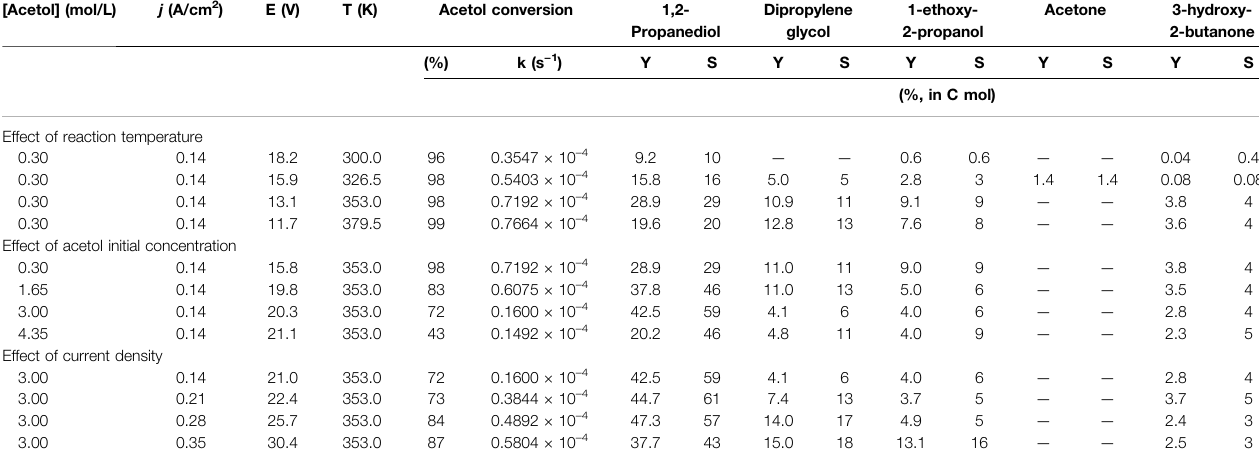
TABLE 1 | 1,2-propanediol and minor products selectivity and yield under different conditions after 8 h of reactions (anode: Pt, electrolyte: 0.3 mol/L Na 2 SO 4 + 9.6% (w/v) Amberlyst-15). [Acetol]